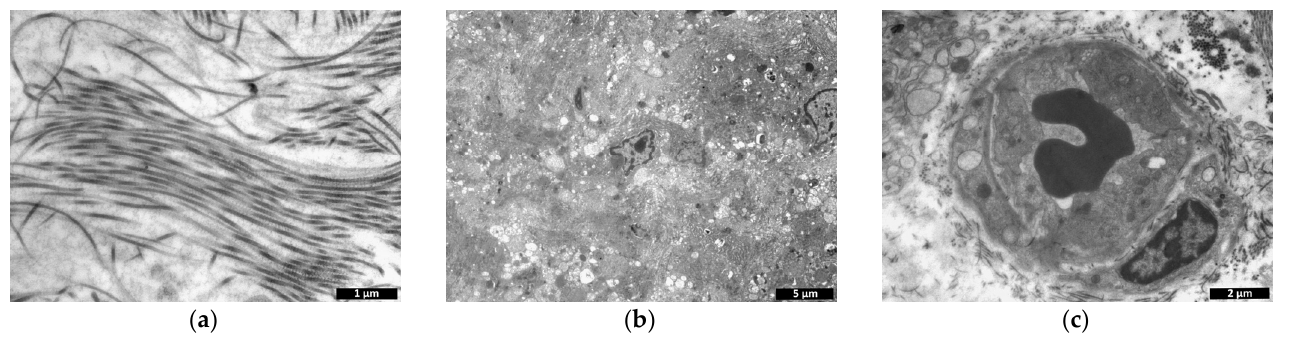
Figure 15. Cell-containing scaffold (transmission microscopy, day 14). ( a )—collagen fibers, ( b )—vesiculation and scaffold uptake by cells, ( c )—capillary.